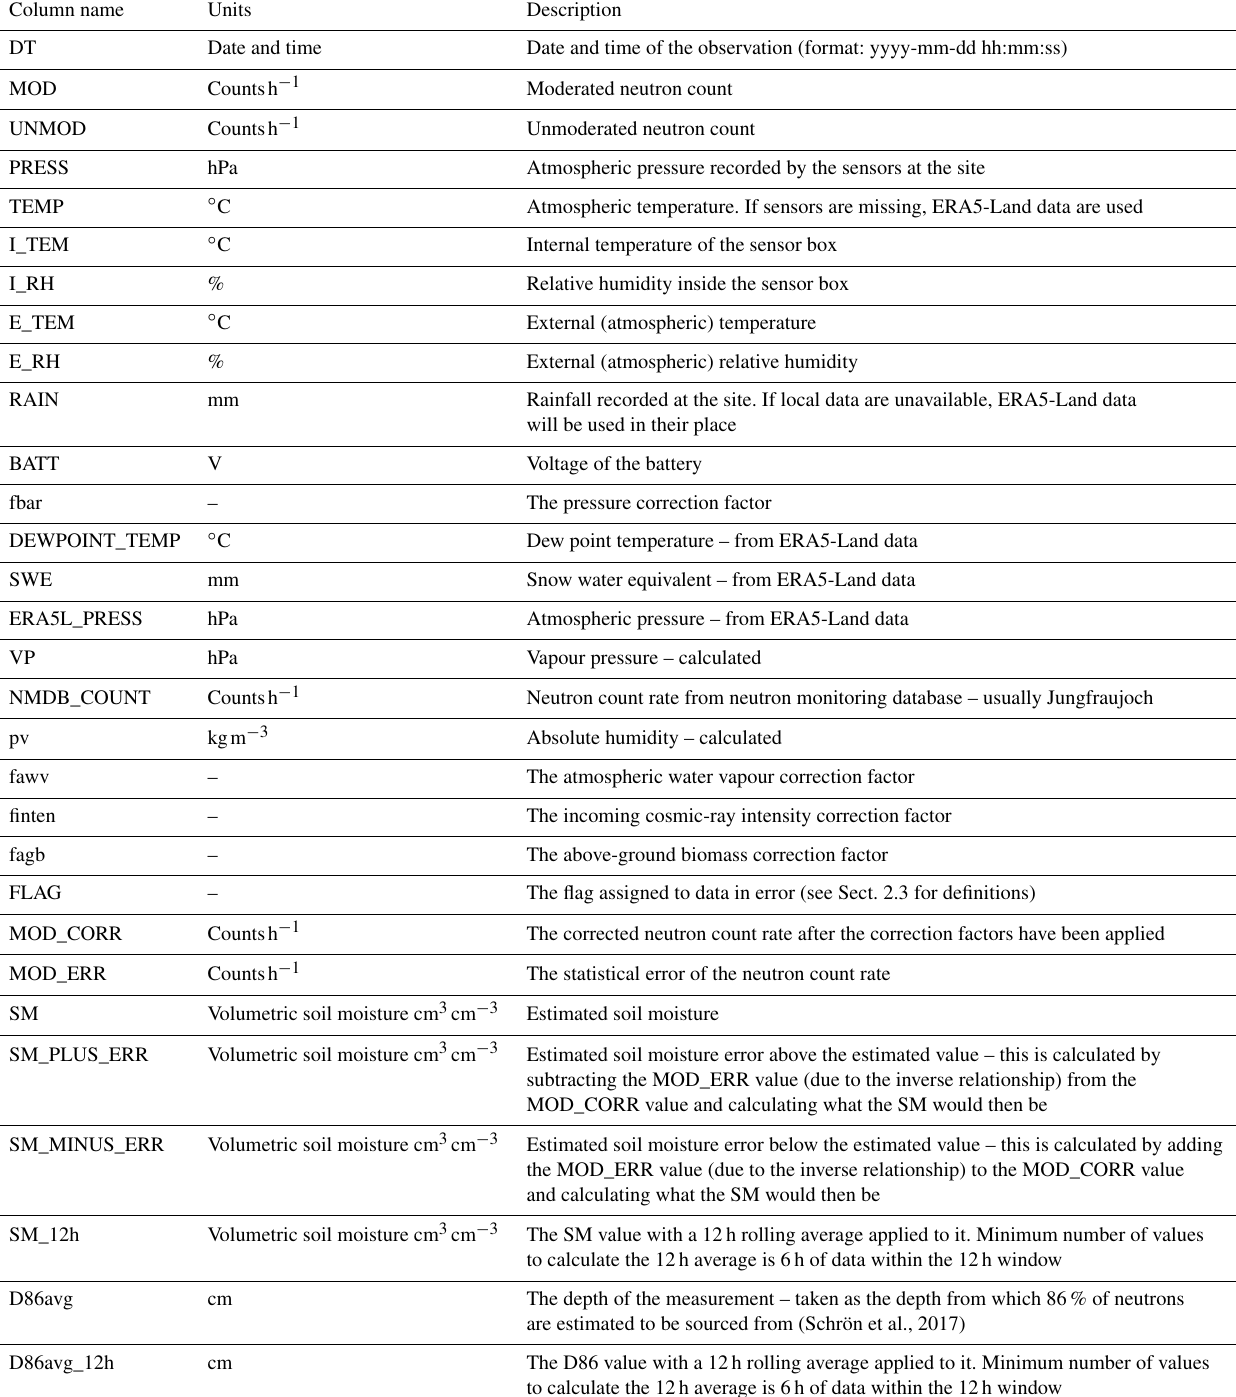
Table A4. crspy final output table from a given CRNS site. Note that there may be additional columns when run as different networks may have additional